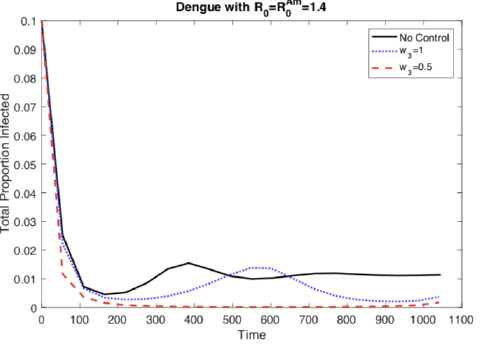
Figure 3. As the relative cost of the control function, w 3 , is reduced, the proportion of infected people decreases. However when the outbreak is dominated by the strain without vertical transmission, ( a ) then the outbreak can be controlled more easily than when the outbreak is dominated by the strain with vertical transmission, ( b ) In the latter case, the cost of control must be reduced even further to effectively control the